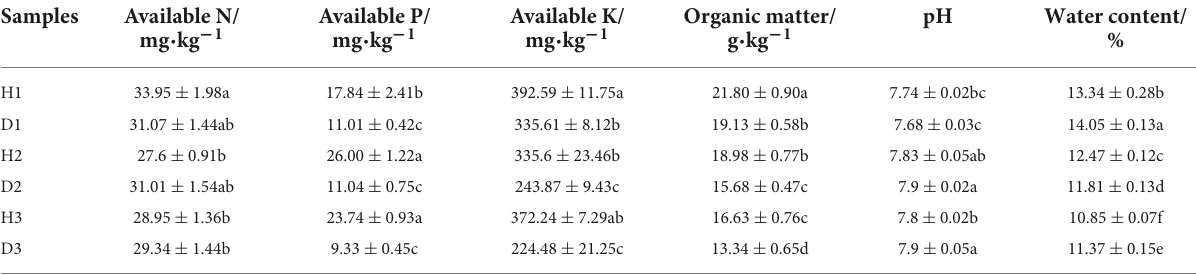
TABLE 1 Physicochemical parameters of the soil samples.